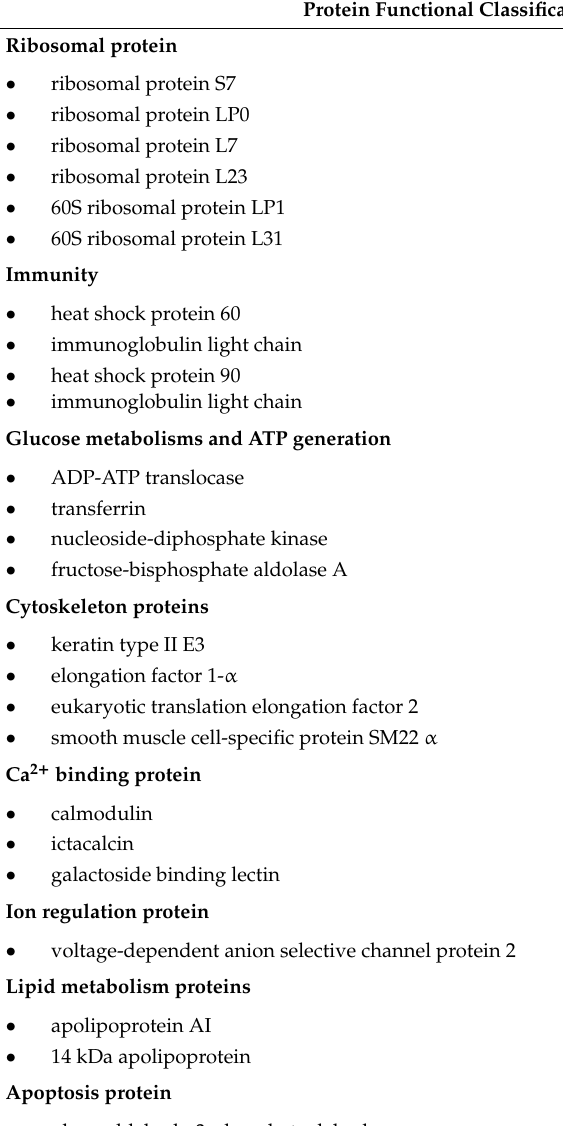
Table 1. Mass spectrometry (MS) analysis of groupers optic nerve proteins that can interact with NNVCP by immunoprecipitation